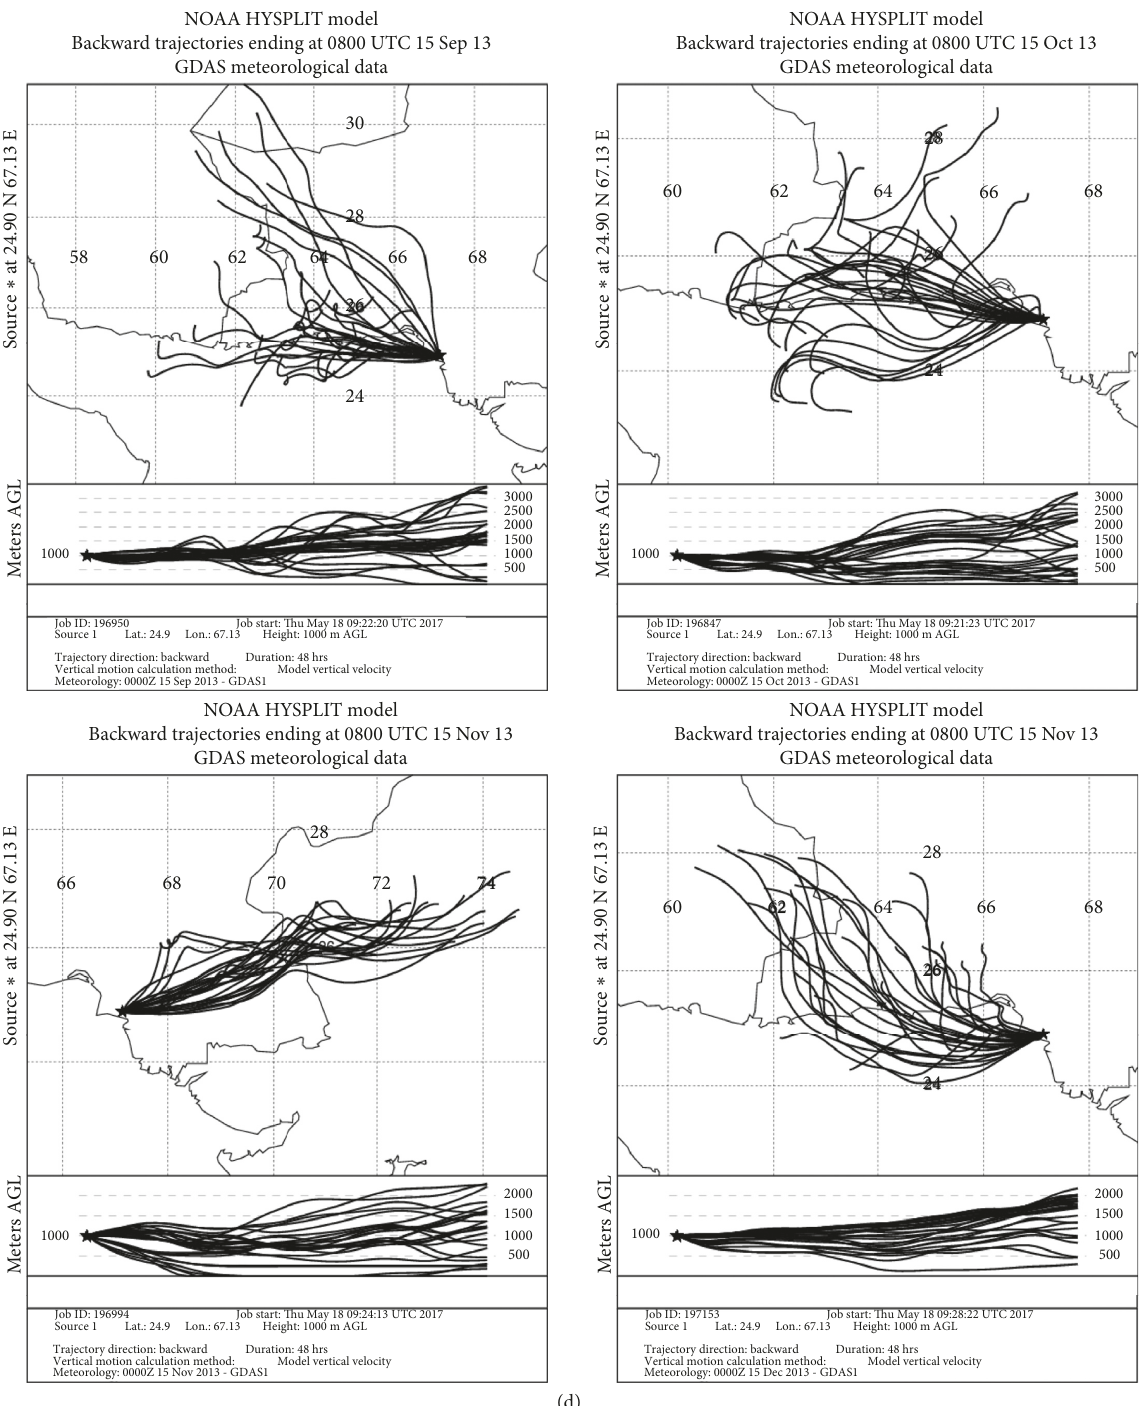
Figure 4: Monthly average variations in the (a) AOD (500 nm), (b) AE (440/870nm), and (c) PW over Lahore during September 2006–August 2014 along with the standard deviations. (d) HYSPLIT model backward trajectories during year